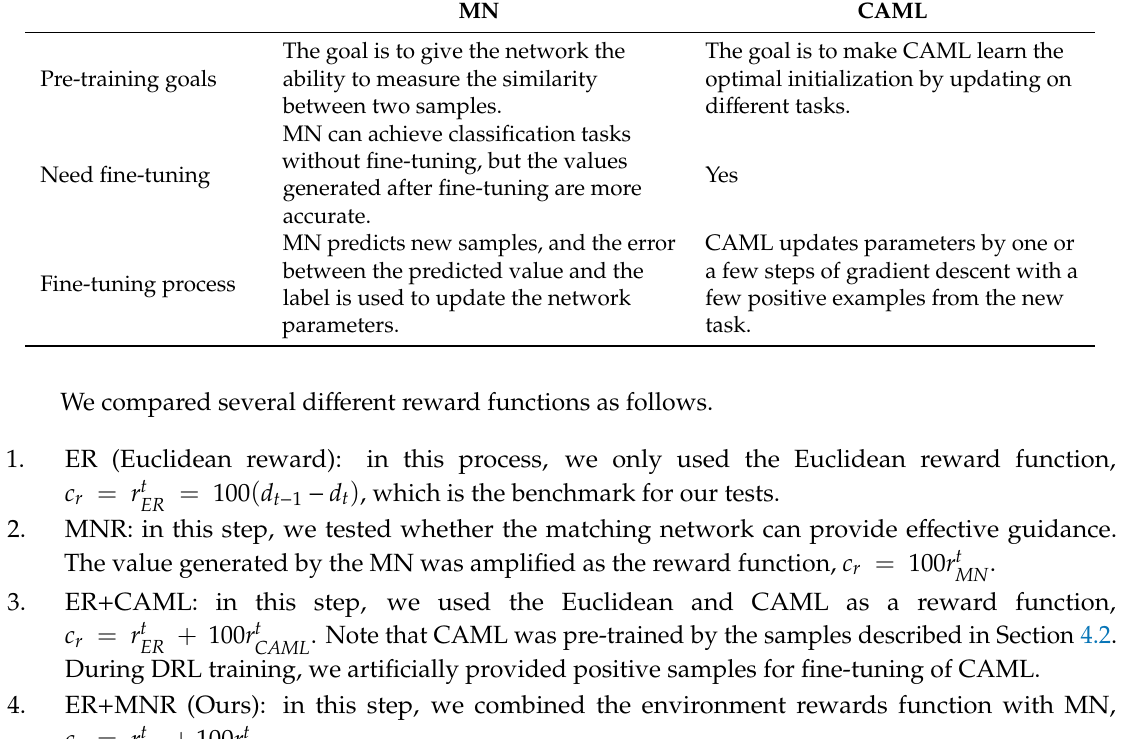
Table 1. Similarities and di ff erences between MN and concept acquisition through meta-learning (CAML). MN CAML